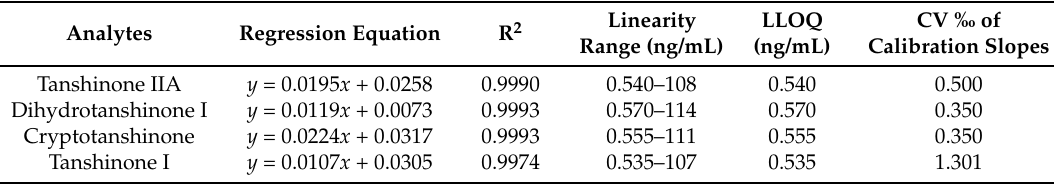
Table 2. The regression equations, linear ranges, correlation coefficient (R 2 ), and LLOQs for four tanshinones in rat plasma ( n = 6).